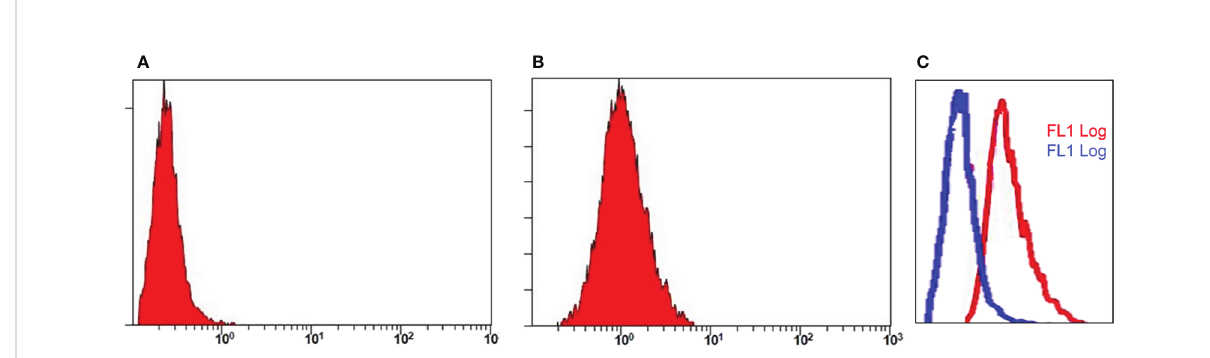
FIGURE 7 Flow cytometry analysis. Assay represents fl uorescence intensity of PD-L1 antibody in negative cell lines, MDA 453 (A) and positive cell lines, A549 (B) . The histogram shifts towards right in (C) indicates high intensity and binding af fi nity of anti-PD-L1 antibody for A549 cells.